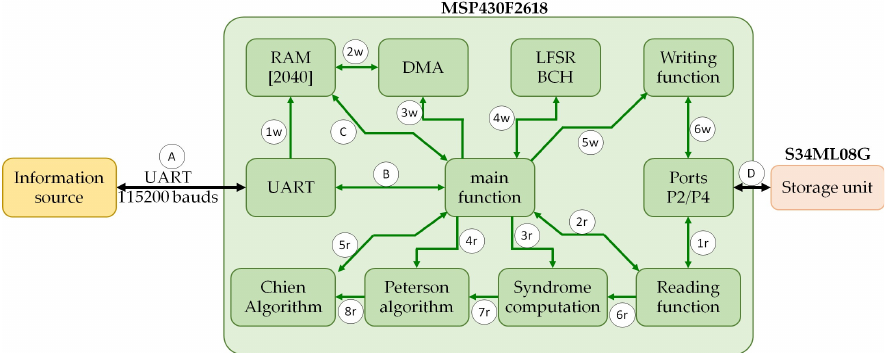
Figure 4. Block diagram of the datalogger software with connections to the information source and the NAND flash memory